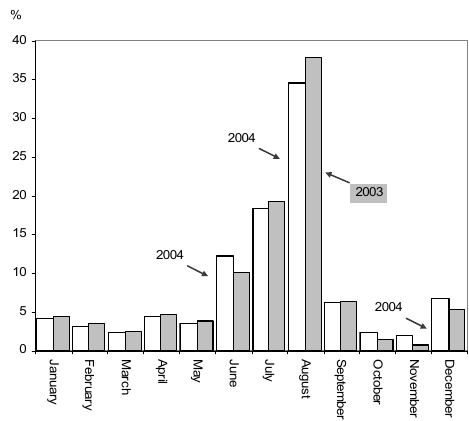
Figure 8 – Monthly distribution of all long holidays (considered at their